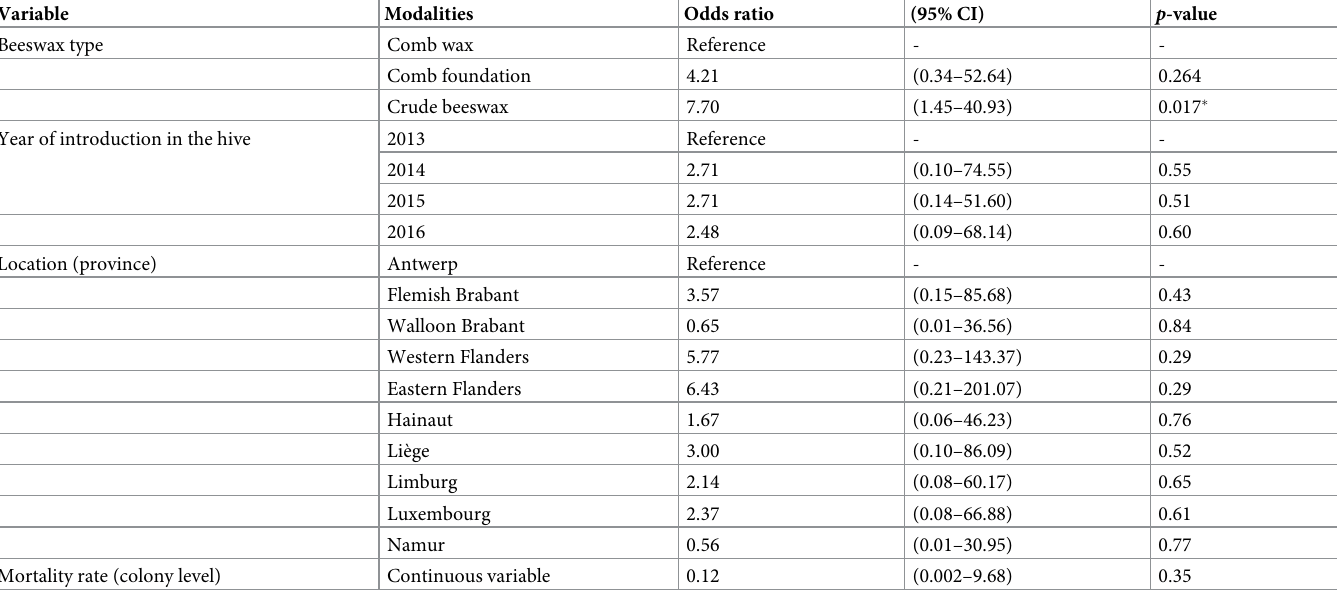
Table 2. Univariate logistic regression analysis for adulterated versus non-adulterated Belgian beeswax samples.